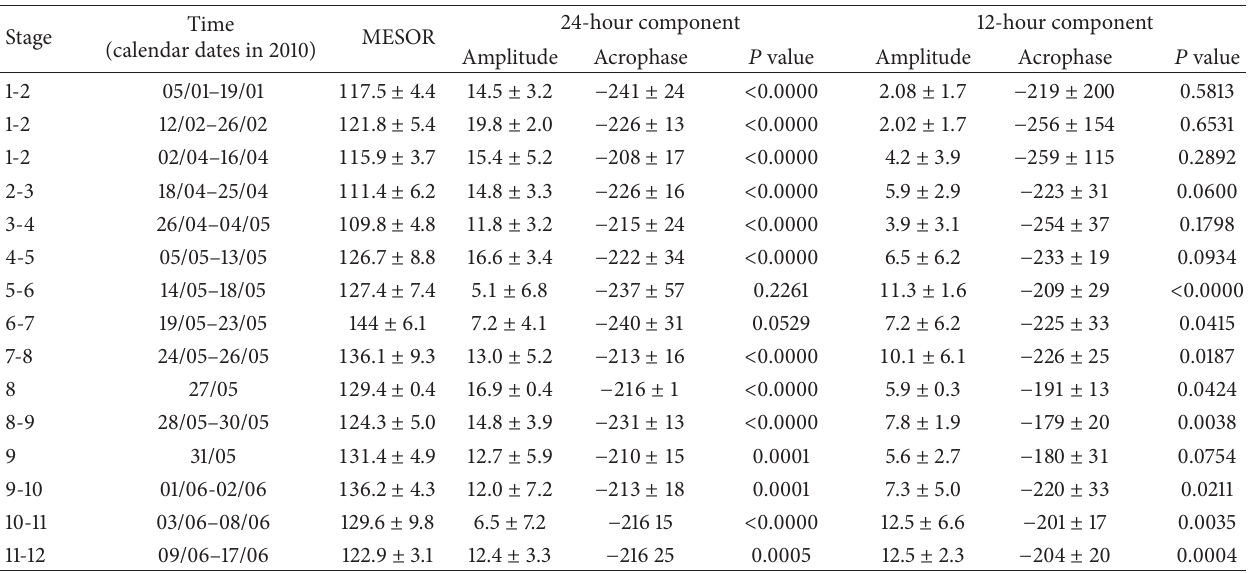
Table 1: Dynamics of the systolic blood pressure in 2010 in the patient GSK.